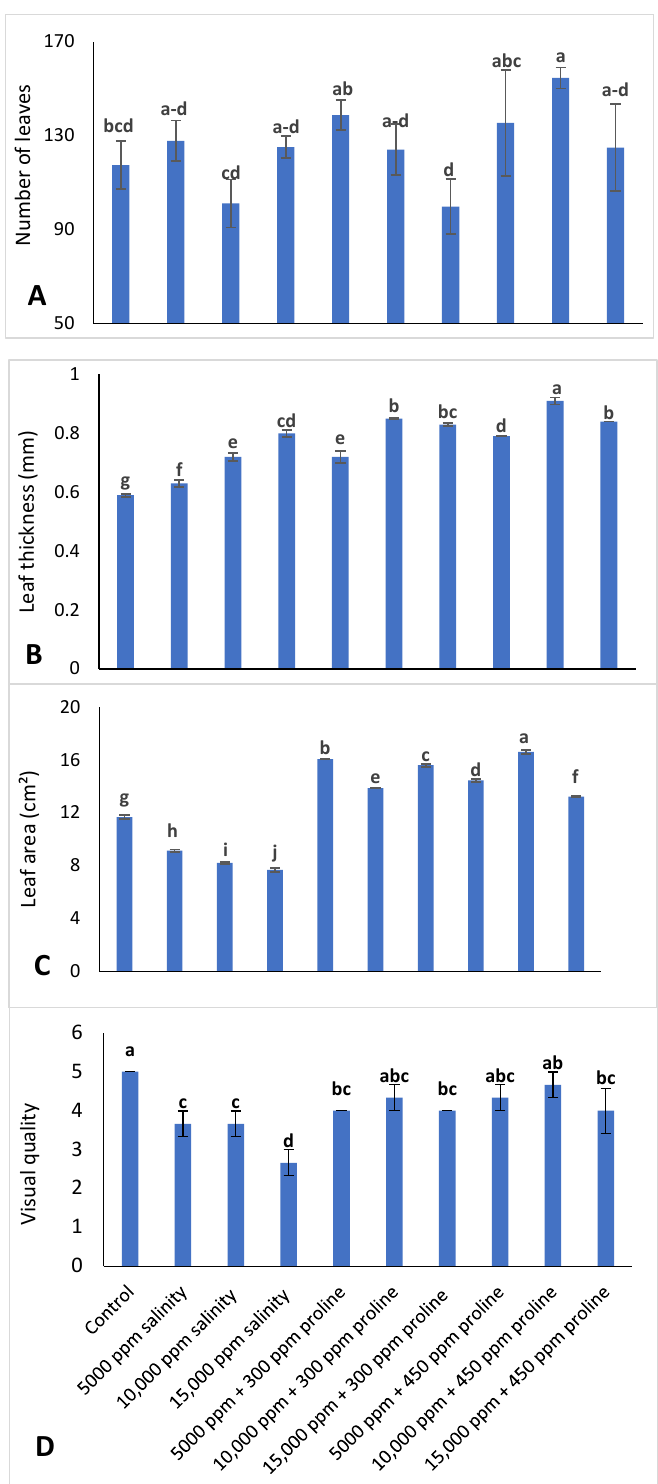
Figure 2. The effect of different levels of seawater salinity and exogenous proline at three concen- trations, 0 ppm, 300 ppm, and 450 ppm on plant height increase percentage ( A ), number of shoot increase percentage ( B ), and stem diameter increase percentage ( C ). Data are means of two seasons (2020 and 2021) and three replicates ( n = 3) for each season. The mean values ± SE of each parameter followed by different alphabetical letters are significantly different according to Duncan’s multiple range test at p ≤ 0.05.